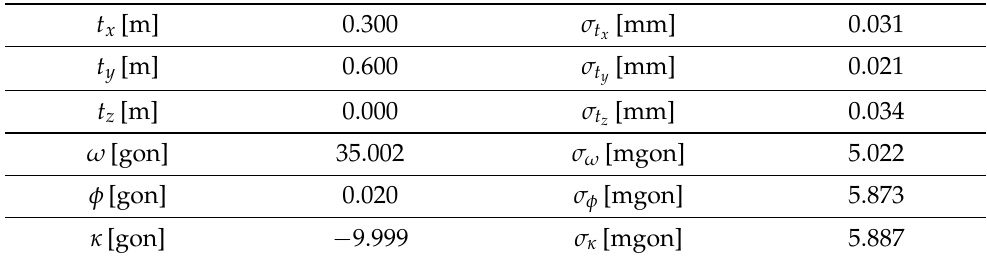
Table A2. Results of the estimated rigid body movement after having extended S CS (data set V20, a = 0, n CS = 21, n CS , ex = 48) [30].